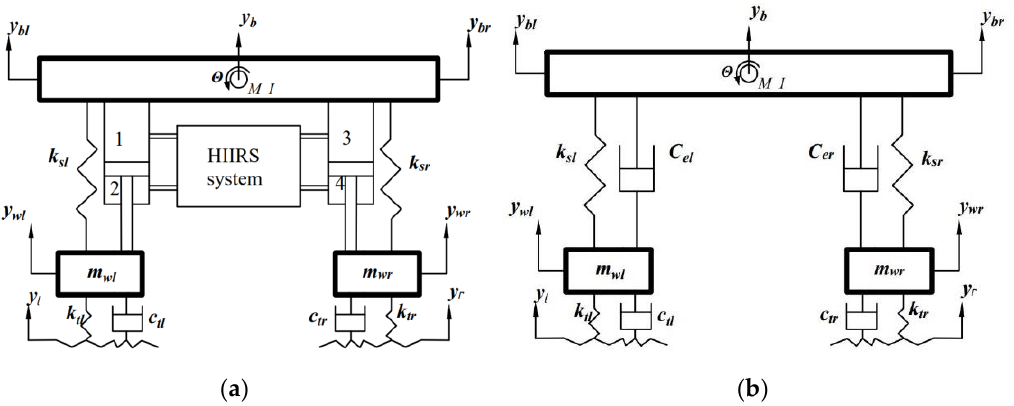
Figure 2. Schematic of a half-vehicle with ( a ) the HIIRS system, and ( b ) the traditional suspension. Table 1. The SUV parameters used in the mechanical subsystem. Symbol Value Units Description M 1400 kg Sprung mass m j 105 kg Unsprung mass ( j = l , r = left, right) I 523 Kgm 2 Sprung mass moment of inertia about the roll axis b j 0.825 M Distance from c.g. to suspension strut ( j = l , r = left, right) kN/m Mechanical suspension spring stiffness Traditional suspension damping